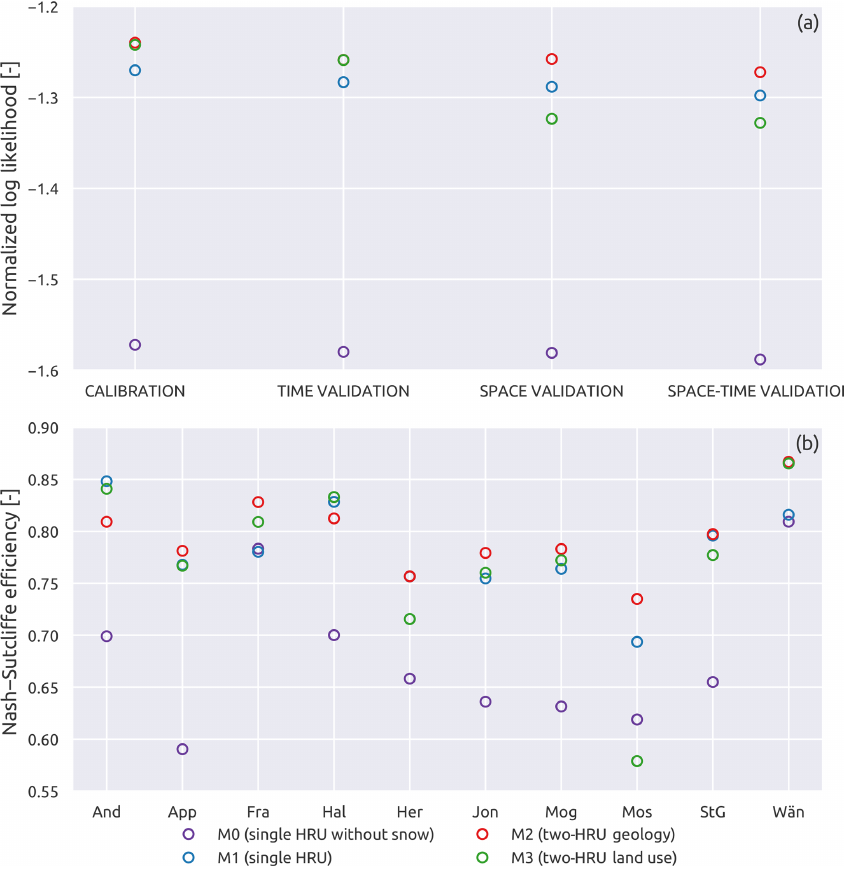
Figure 7. Normalized log likelihood (a) and Nash–Sutcliffe efficiency (b) for the three model configurations. (a) reports the variation between calibration and validation of the average of the 10 subcatchments; (b) shows the variation between subcatchments during space– time